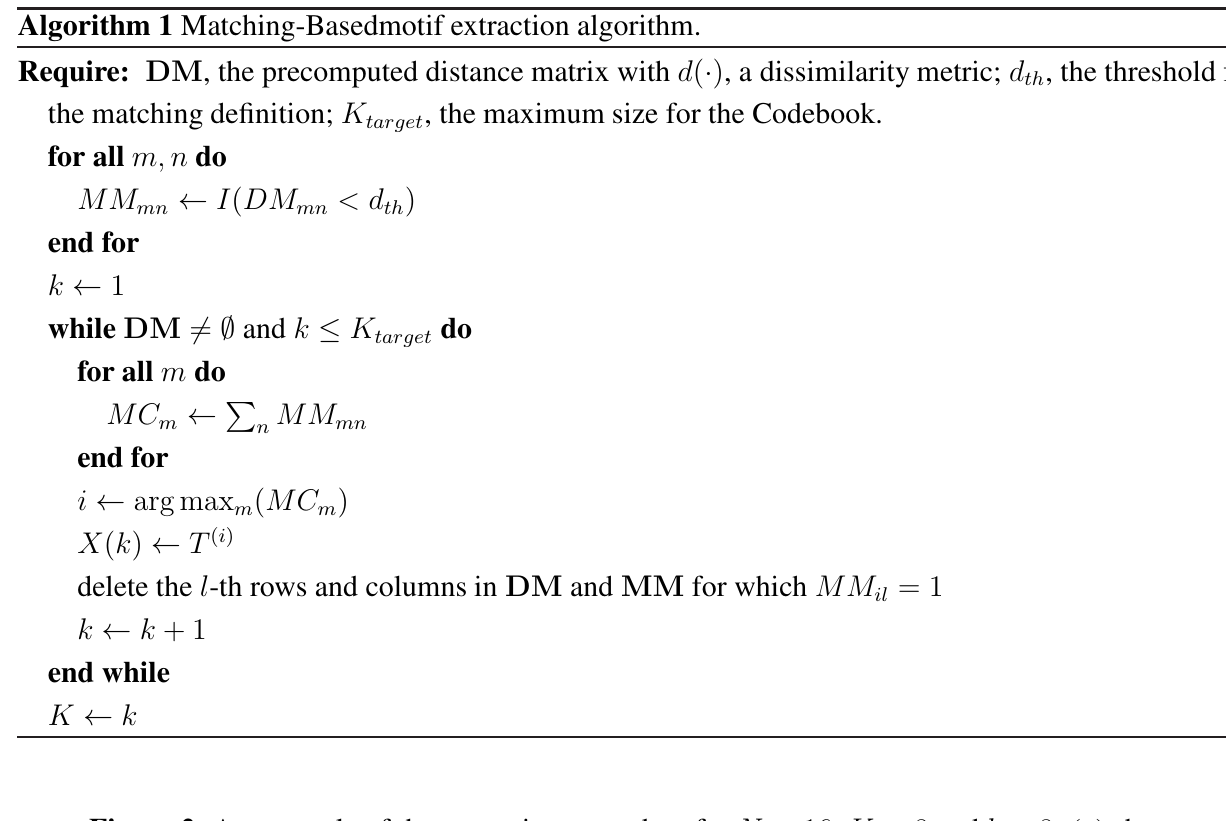
Figure 2. An example of the extraction procedure for N = 16 , K = 8 and b = 8 : ( a ) shows a given training set, highlighting, in bold red, the segments selected to form the